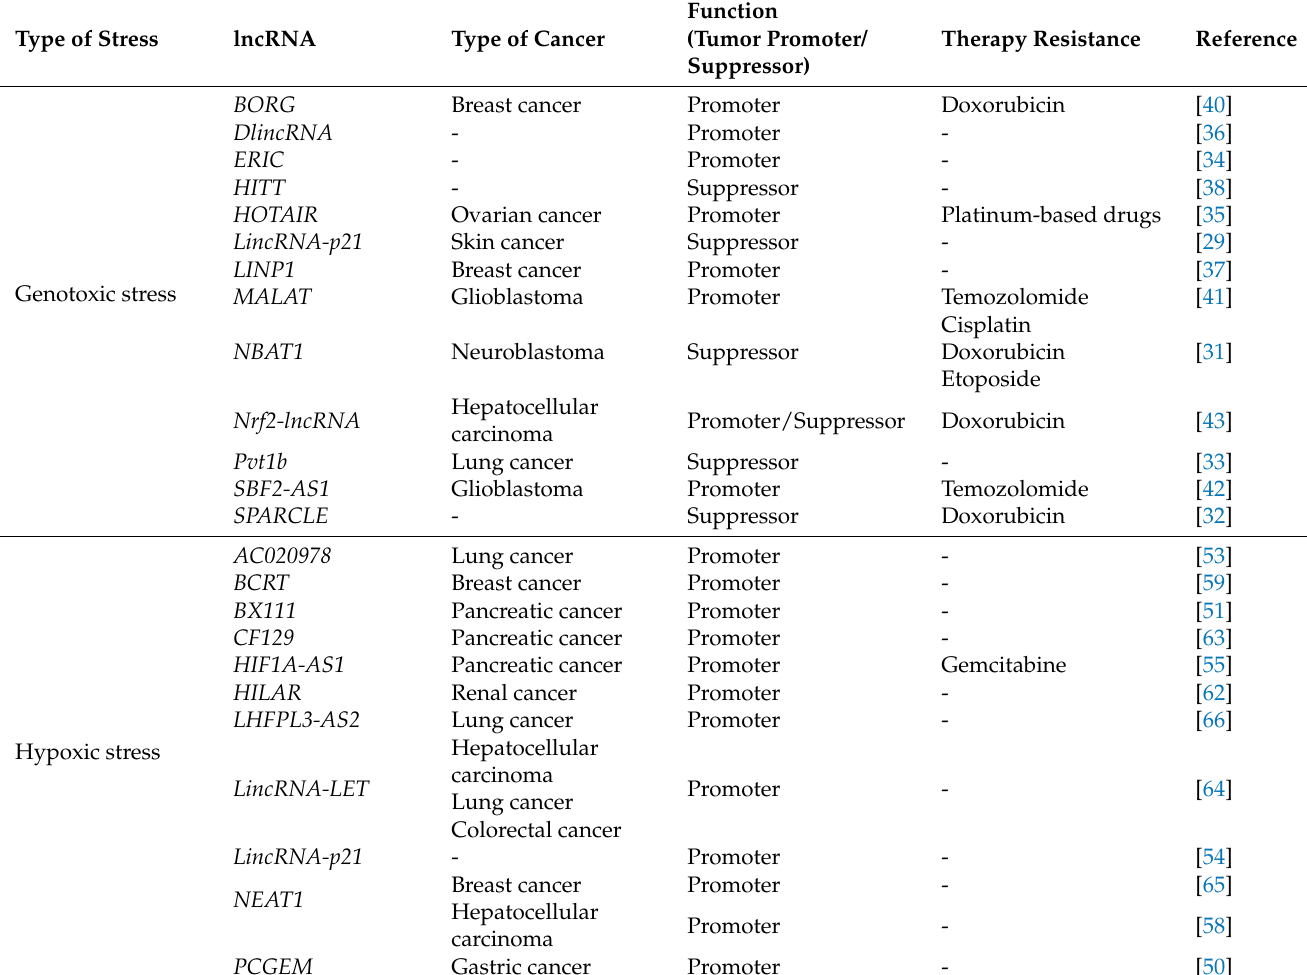
Table 1. List of stress-responsive lncRNAs associated with cancer progression and therapy resistance.